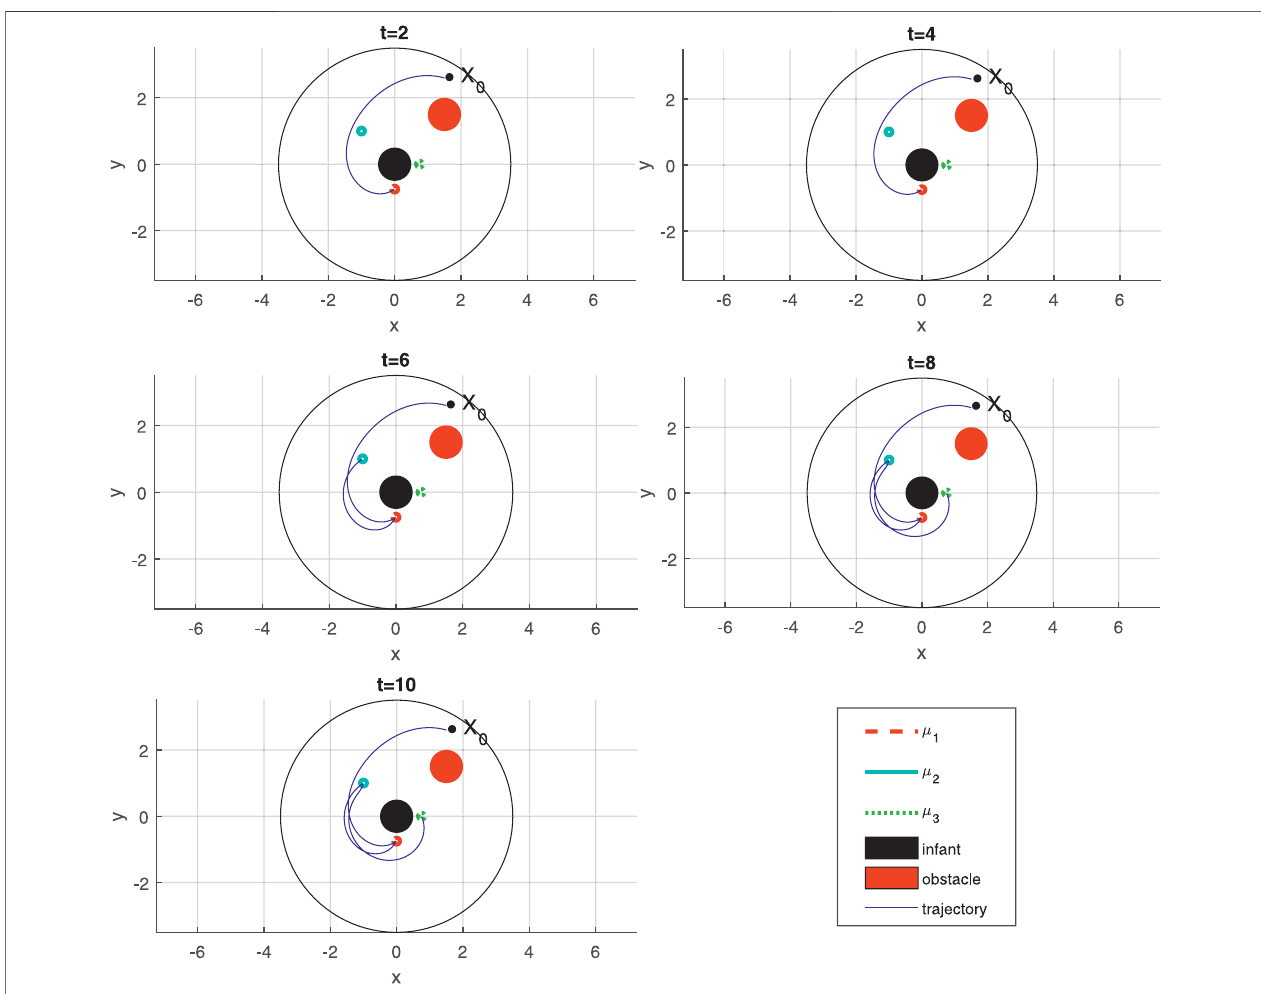
FIGURE 7 | Trajectory of the Dash for STL task φ 3 ( 30 ) at different time instances, with time label at the top of each fi gure.